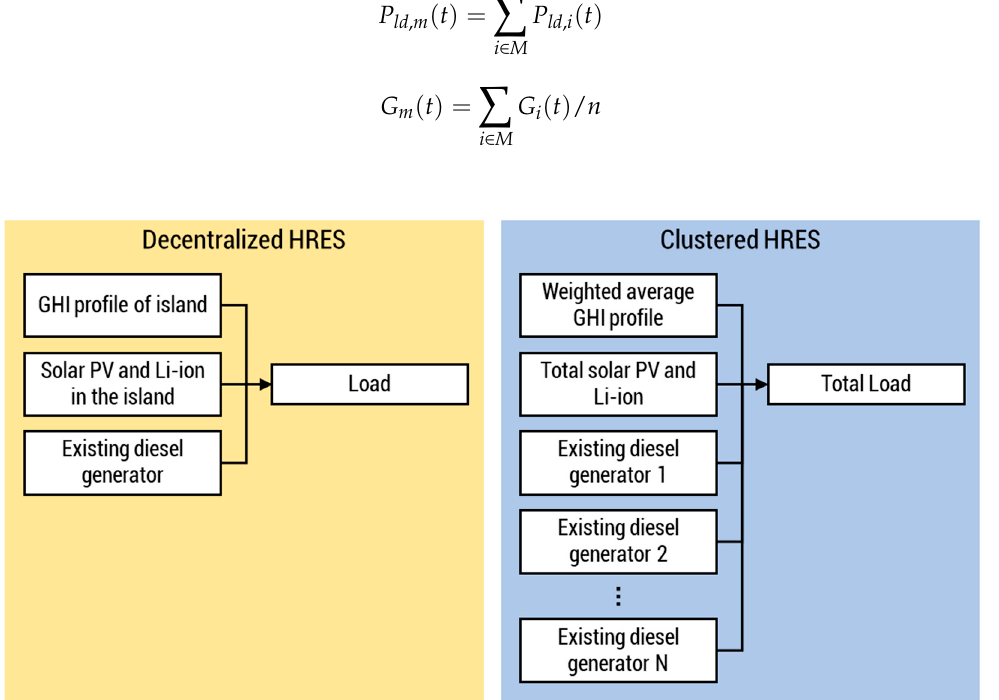
Figure 4. System architecture simulated in HOMER Pro for decentralized ( left ) and clustered ( right ) HRESs.